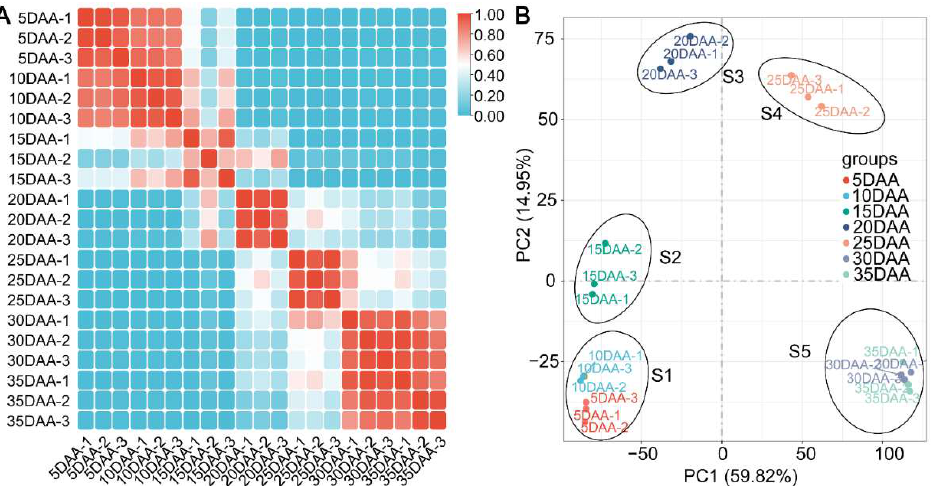
Figure 2. ( A ) Correlation analysis and ( B ) principal component analysis (PCA) of all samples during seed development. The seven stages were classified into five developmental stages, S1 (5–10 DAA), S2 (15 DAA), S3 (20 DAA), S4 (25 DAA) and S5 (30–35 DAA), based on correlation and principal component analyses.